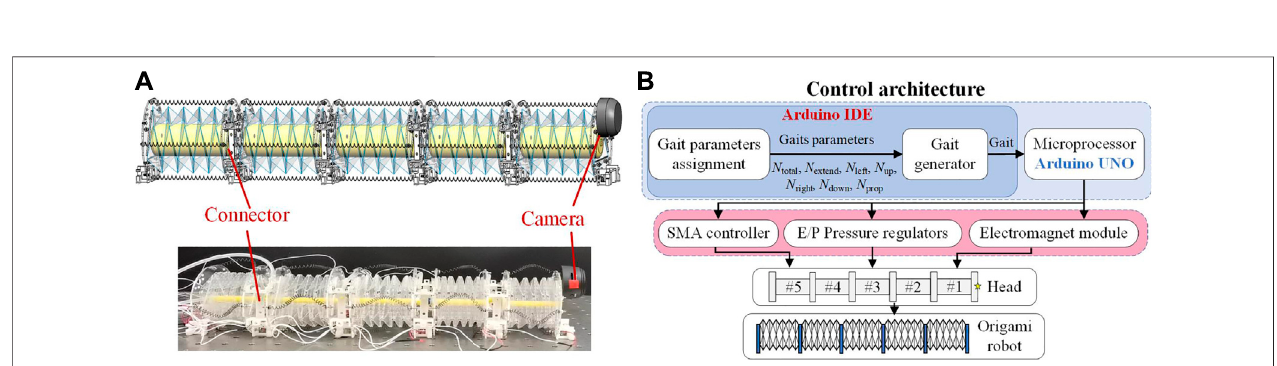
FIGURE 11 | Prototype of a fi ve-segment Yoshimura-ori-based earthworm-like robot and its control architecture. (A) CAD design and photo of the fi ve-segment origami-based earthworm-like robot prototype. (B) Gait control architecture of the earthworm-like metameric robot.